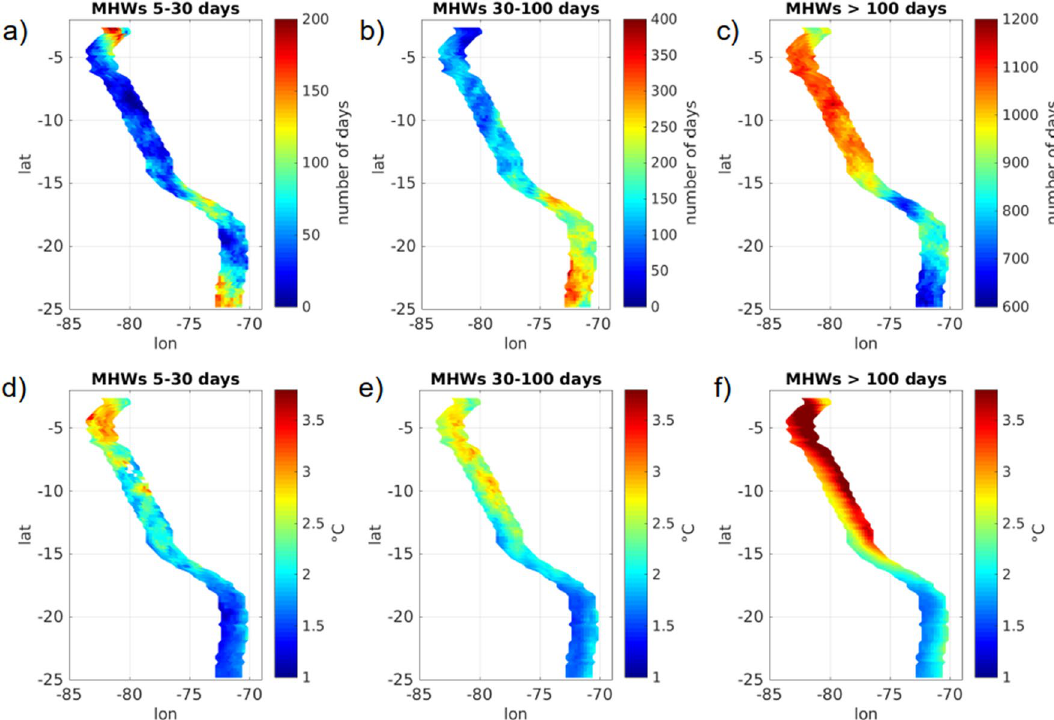
Figure 3. ( a – c ) Exposure to MHWs, expressed as the number of days affected on each data point and ( d – f ) averaged SST anomaly for MHWs of duration ( a , d ) 5–30 days, ( b , e ) 30–100 days and ( c , f ) longer than 100 days. The figure was created using Matlab R2020b (https:// matlab. mathw orks. com/).